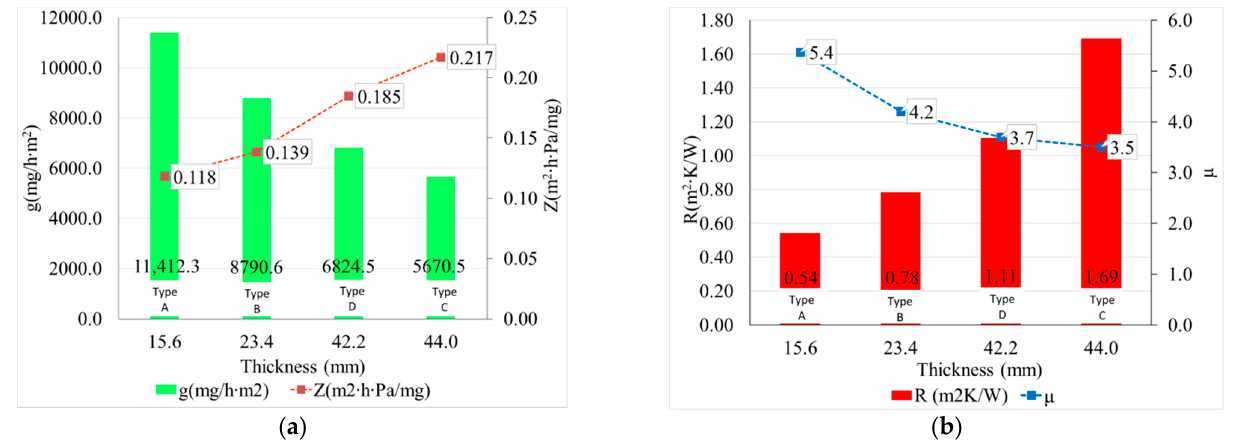
Figure 5. Water vapor permeability quantified by water vapor transmission rate, g (mg/hm 2 ), water vapor resistance, Z (m 2 h Pa/mg), and water vapor resistance factor, µ: ( a ) presented in order of increase in their thickness, respectively ( b ) in correlation with their thermal transfer resistance (Types A, B, C, D defined according to Table 2).